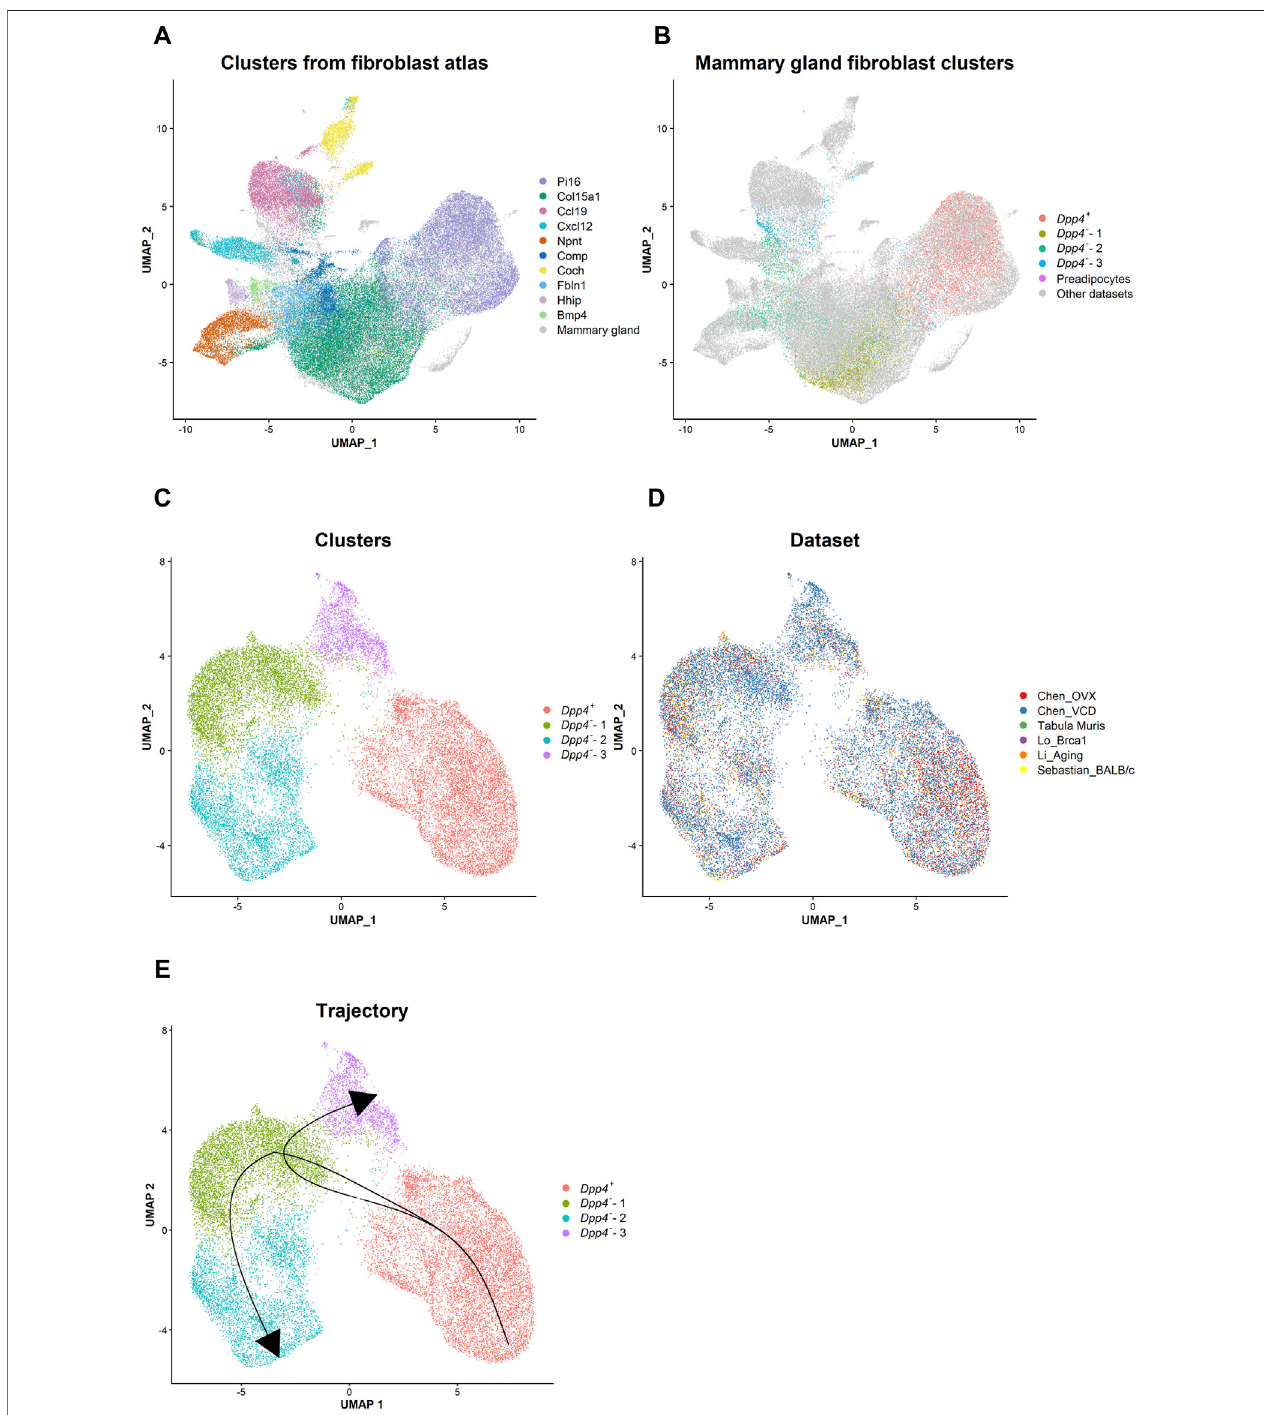
FIGURE 5 | Integrative analysis reveals the lineage trajectory of mouse mammary gland fi broblasts. (A) The distribution of the steady state fi broblast clusters (Buechler etal., 2021)intheUMAP plotafter thedataintegration withthemammarygland fi broblast datasets usingtheHarmony Rpackage. Eachcell isrepresentedby each dot ( n = 82,410) and is colored according to the clusters identi fi ed in the paper from Buechler et al., 2021. Mammary gland fi broblasts are colored in gray. (B) The distributionofthemammarygland fi broblast clustersidenti fi ed inourowndataset intheUMAPplot. Each cellfromourdataset (Chen_OVX/VCD)isrepresentedby each dot and is colored according to the mammary gland fi broblast clusters as indicated in Figure 1B . The cells from the other datasets are colored in gray. (C,D) The UMAP plotoftheintegratedmammarygland fi broblast dataset.Each cellisrepresented byeach dot( n =21,861)andiscoloredaccordingto (C) theclusteridenti fi edby theunbiasedclusteringand (D) theoriginateddatasets. (E) Thelineagetrajectoryofmammarygland fi broblastsinferredbytheSlingshotRpackage.Theprincipalcurve was generated based on the pseudotime shown in Supplementary Figure S4C .